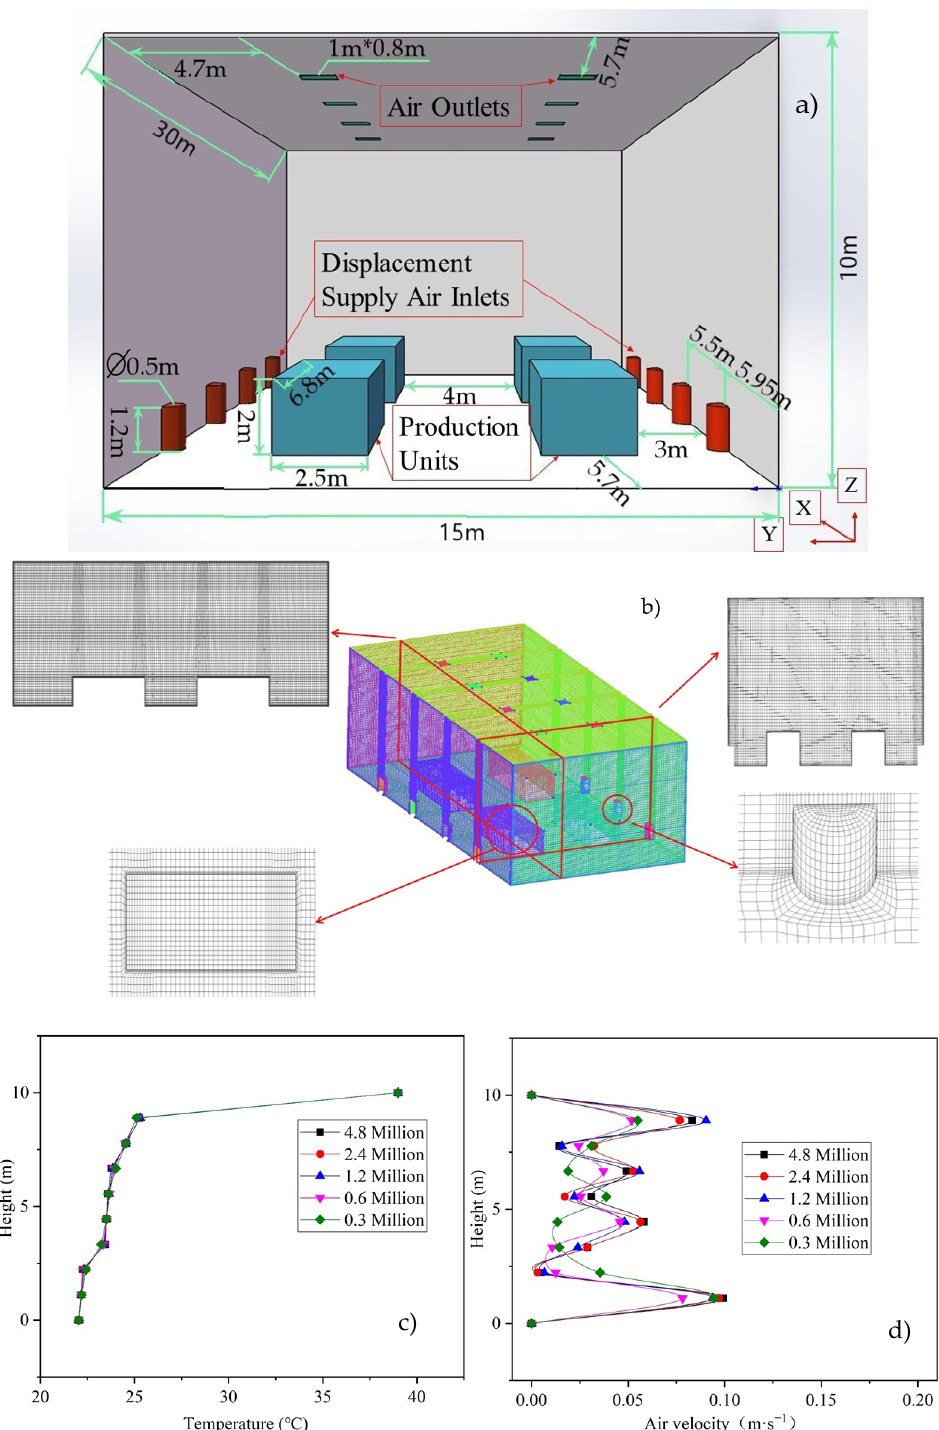
Figure 4. Geometric model, computational mesh, grid refinement information, and grid-independent verification results. ( a ) Geometric model used in this study, ( b ) computational mesh and grid refinement information, ( c ) temperature result of grid-independent verification, and ( d ) air velocity result of grid-independent verification.